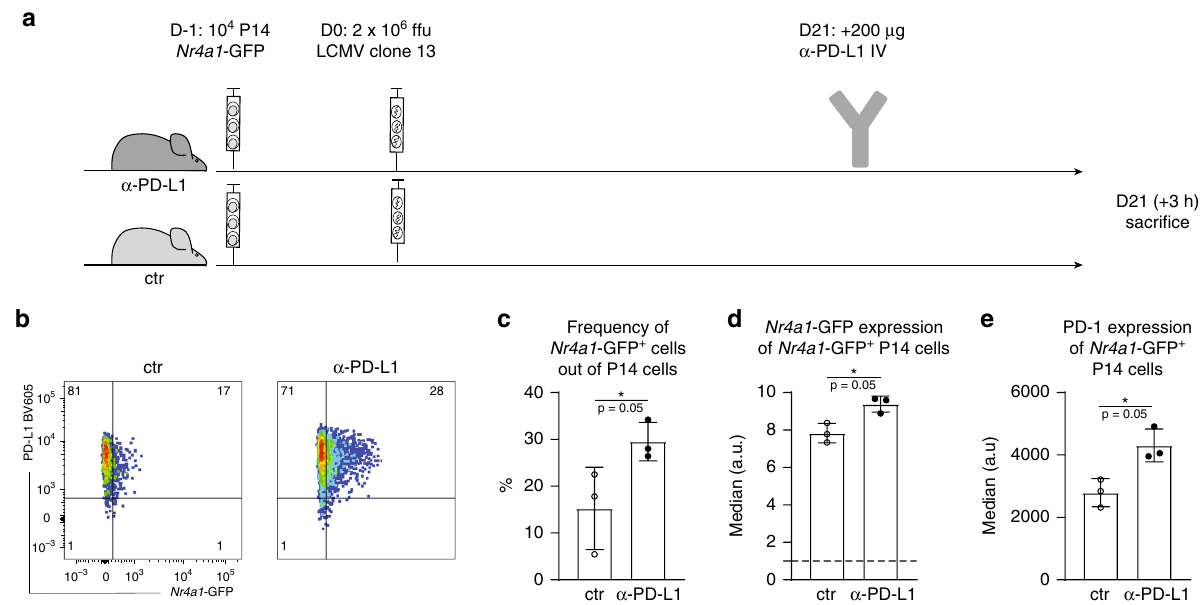
Fig. 6 Increase in TCR signaling after short-term PD-L1 blockade. a P14- Nr4a1 -GFP were adoptively transferred into naive hosts 1 day prior high-dose LCMV clone 13 infection. Twenty-one days post infection, one group received one dose of anti-PD-L1 blocking antibody intravenously. The mice were sacri fi ced 3 h after treatment. b Representative plots showing Nr4a1 -GFP signal in two groups, control (ctr) and treated ( α -PD-L1) are shown. Fraction of Nr4a1 -GFP + cells (gated on alive single CD8 + CD45.1 + P14 cells) ( c )), median of GFP ( d ) and PD-1 ( e ) (gated on alive single CD8 + CD45.1 + CD45.1 GFP + cells) are shown for cells isolated from the spleen. Bar plots represent mean ± SD. Asterisk (*) represents p -value = 0.05 (Mann – Whitney one- tailed-test). One of three experiments is shown ( n = 3 mice). Each dot represents an individual mouse. See also Supplementary Figs. 4 and 5. Source data are provided as a Source Data (Thermo fi sher Scienti fi c) according to the manufacturer ’ s protocol and processed for sequencing at the Functional Genomics Center Zürich (FGCZ). The extracted RNA was selected for messenger RNA (mRNA) transcripts using polyA-tail cap- ture. The enriched mRNA was reverse transcribed and sequenced on the Illumnia HiSeq 4000 platform. Resulting transcript counts were analyzed and differential gene expression was analyzed using the DEseq2 package 45 in R 46 . Mice . Wild-type male CD45.2 C57BL/6J mice purchased from Janvier Elevage, Nr4a1 -GFP mice expressing GFP under the control of the NUR77 promoter 24 , Tcf7 -GFP mice expressing GFP under the control of Tcf7 (encoding TCF1) pro- moter 21 , P14 transgenic (CD45.1) mice expressing a TCR speci fi c for LCMV peptide gp 33 – 41 47 were housed at 24°C and 50% humidity and bred under speci fi c pathogen-free conditions at the ETH Phenomics Center Hönggerberg. Mice were exposed to a 12:12 h light – dark cycle with unrestricted access to water and food. All mice used in experiments had between 6 and 16 weeks. P14- Nr4a1 -GFP or P14- Tcf7 -GFP were generated by crossing Nr4a1 -GFP or Tcf7 -GFP mice to P14 mice. All animal experiments were conducted according to the Swiss federal regulations and were approved by the Cantonal Veterinary Of fi ce of Zürich (Animal experi- mentation permissions 147/2014, 115/2017). Virus . LCMV clone 13 was propagated on baby hamster kidney 21 cells (BHK21 [C13] (ATCC ® CCL10). Viral titers of virus stocks were determined as described previously by using MC57G (ATCC ® CRL-2295) cells 48 .